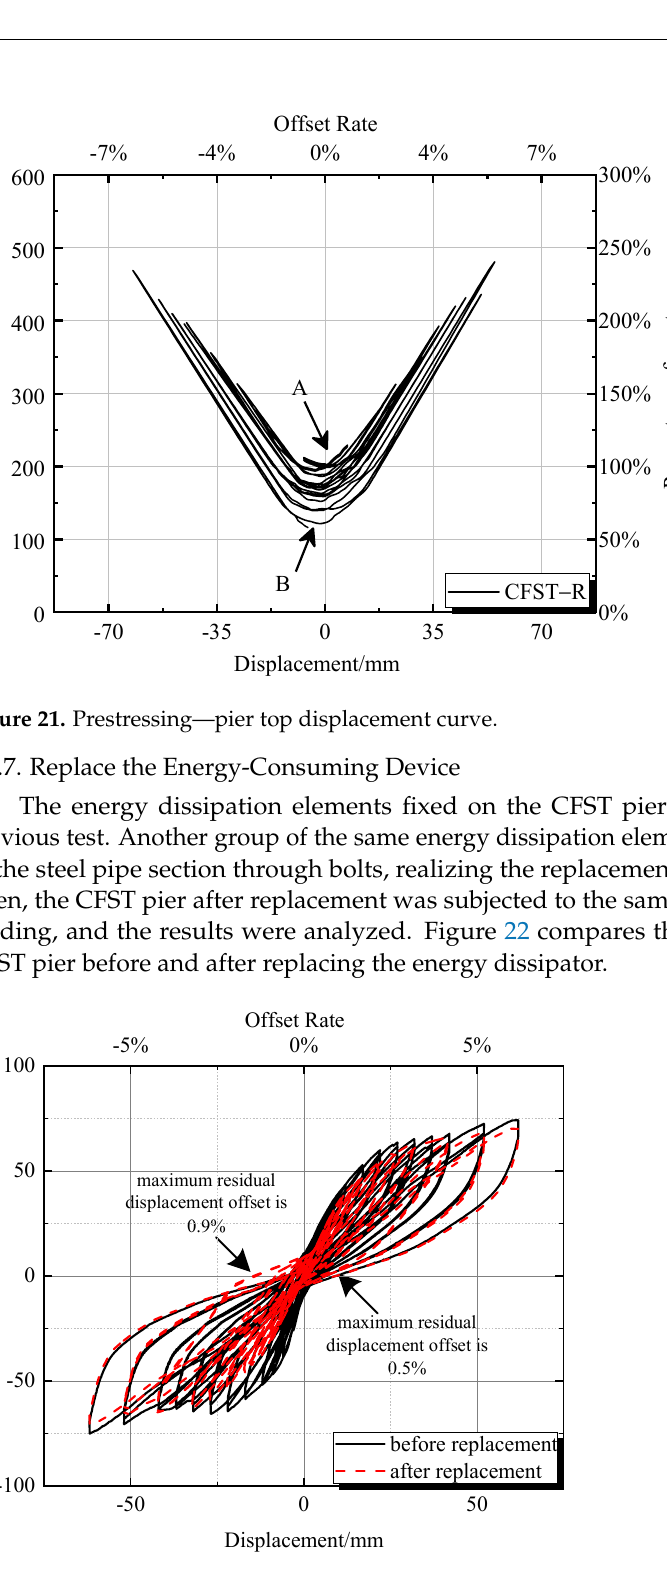
Figure 22. Comparison of hysteresis curves before and after replacement. It can be seen from Figure 22 that the hysteretic curves of the model before and after replacement are basically the same, and both curves are relatively full. The maximum lateral bearing capacity of the test piece of the bridge pier before replacement was 74.05 kN, and the maximum lateral bearing capacity of the test piece of the bridge pier after replacement was 68.95 kN, which was reduced by 6.8%. The maximum residual displacement deviation rate of the CFST pier specimens before replacement was 0.5%, and the maximum displacement offset is